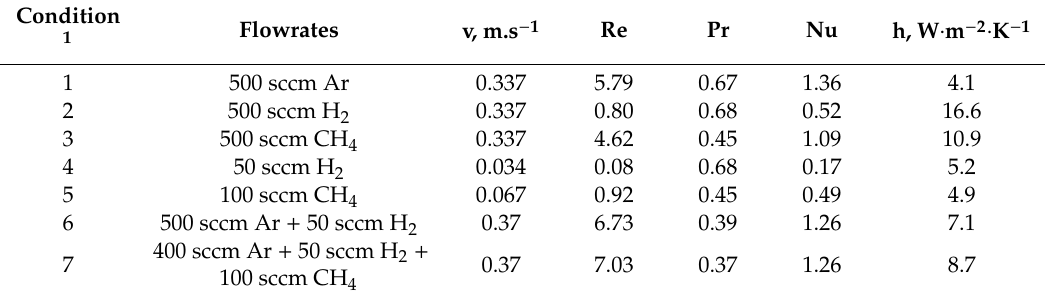
Table 1. Calculated convective heat transfer around a copper foil at di ff erent reactor conditions 1